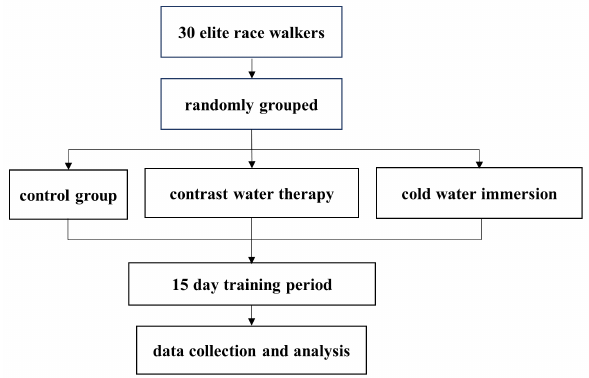
Fig. 1. Experimental designs and